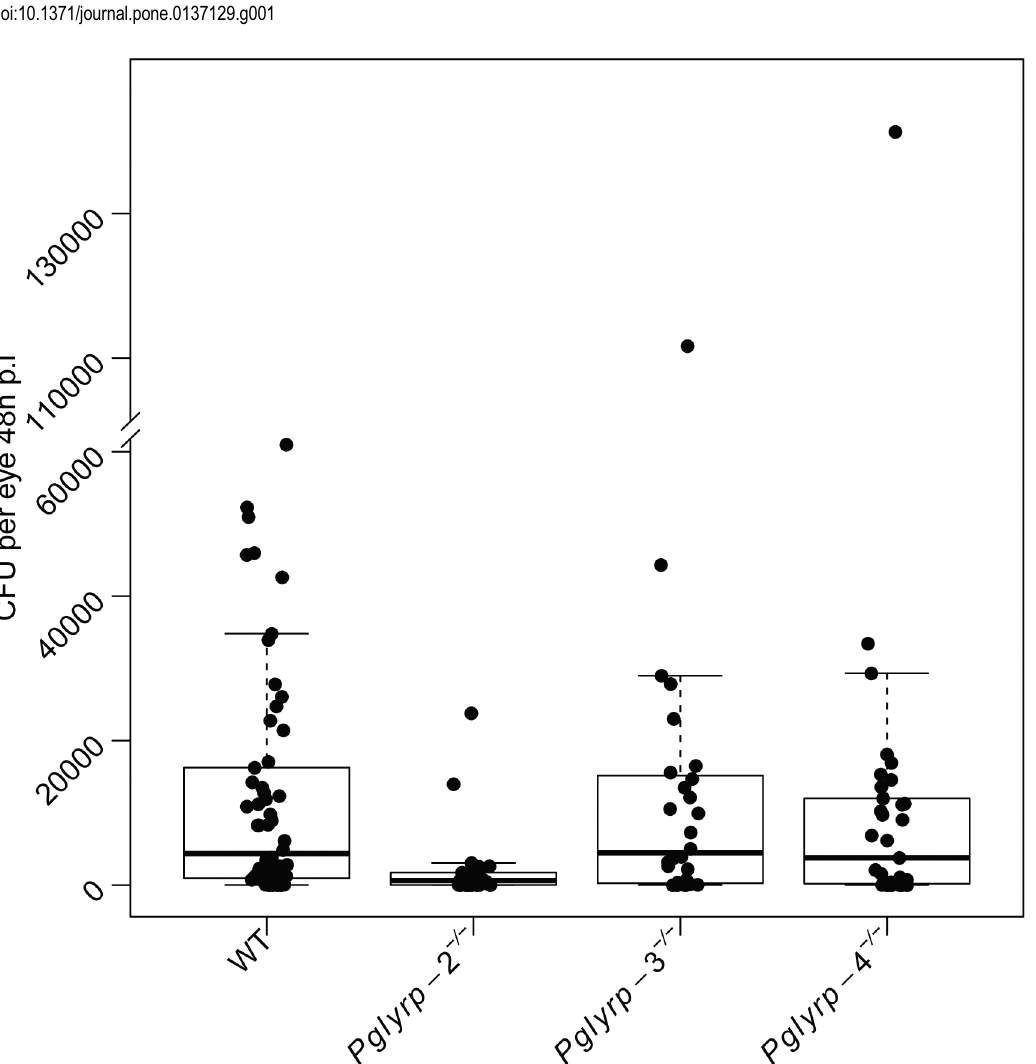
Fig 2. Improved bacterial clearance in the Pglyrp -2 -/- mice. Dilutions of whole eye homogenates from mice harvested at 48.h.p.i were plated to obtain colony forming unit counts (CFU) per eye. Uninfected eyes did not yield viable bacteria (not shown). The Pglyrp -2 -/- mouse eyes showed significantly lower viable CFU (t = -3.45, p-value = 0.0007). Bacterial yield in Pglyrp -4 -/- mice were also lower than WT (t = -1.66, p-value = 0.098). Bacterial yields together with their corresponding clinical scores are shown in S1 Fig. doi:10.1371/journal.pone.0137129.g002 PLOS ONE | DOI:10.1371/journal.pone.0137129 September 2,